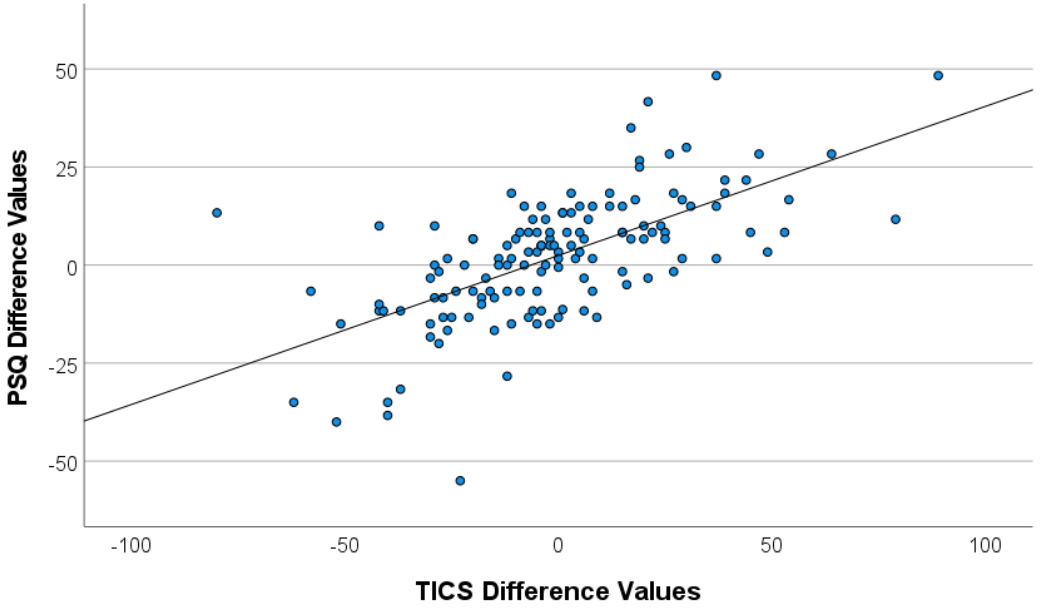
Figure 2. Scatterplot of pre-/on-COVID difference values of PSQ and TICS.